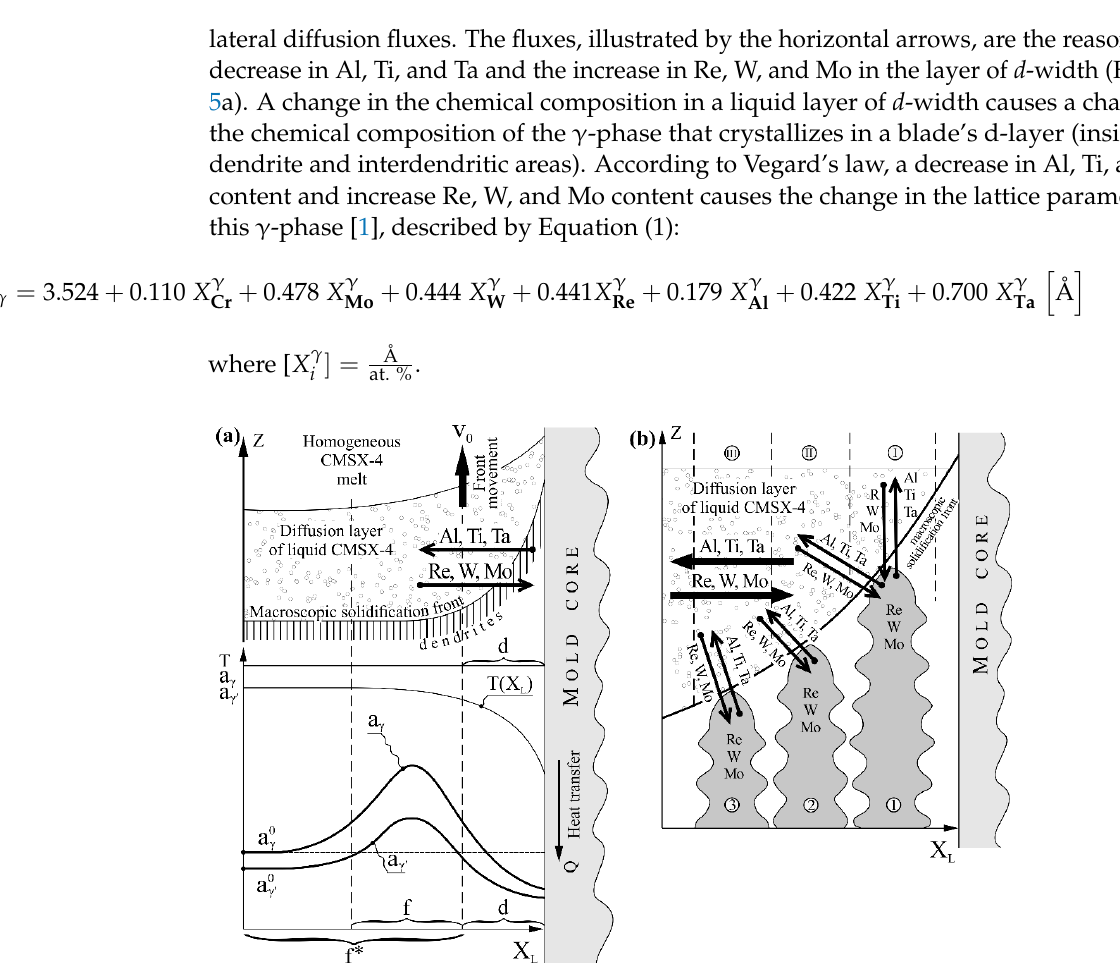
Figure 5. Scheme of formation of alloying elements distribution parallel to the X L axis near the mold core for curved macroscopic crystallization front, as well as, distribution of lattice parameters a γ and a γ′ ( a ) and scheme of the Al, Ti, and Ta and Re, W, and Mo diffusion fluxes formation by dendrite tips ( b ).